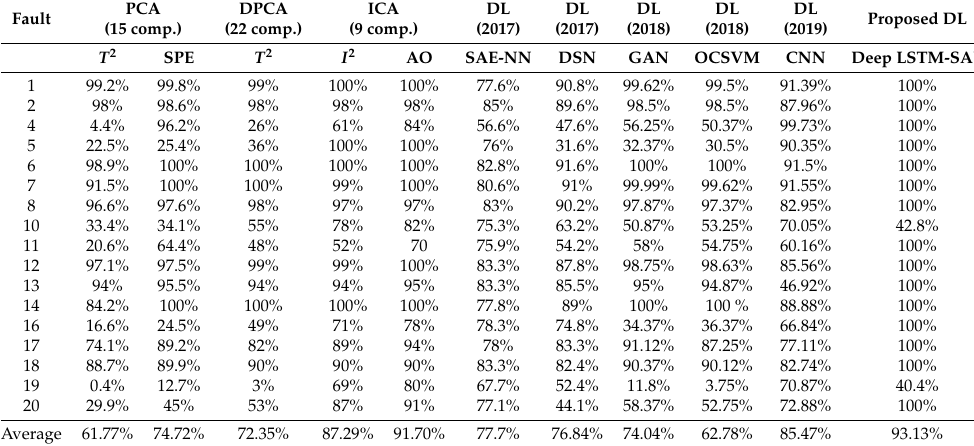
Table 3. Comparison of Fault Detection Rate with different methods with non-incipient faults only. PCA DPCA ICA Fault (15 comp.) (22 comp.) (9 comp.)